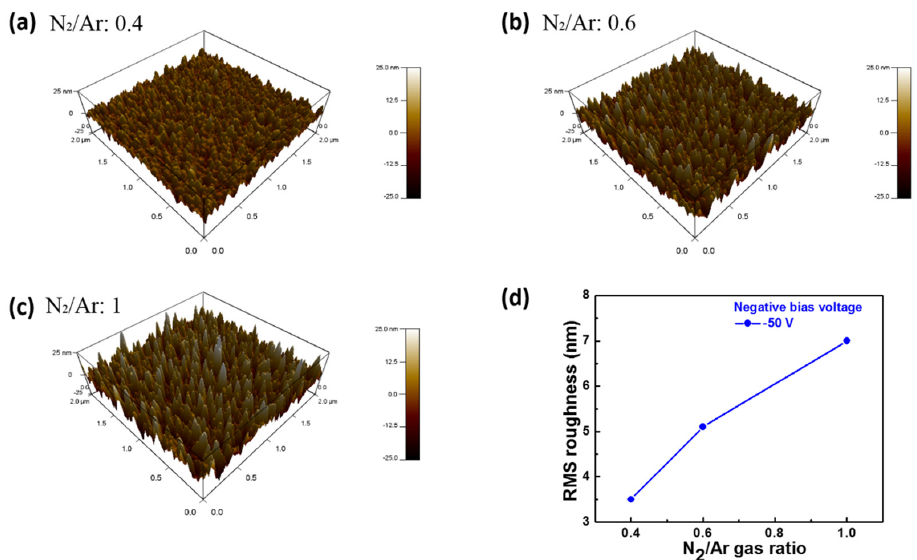
Figure 6. The three-dimensional topographic AFM images of the typical NbN x >1 samples ( a – c ), and Root Mean Square (RMS) roughness deposited at different N 2 /Ar gas ratios with constant − 50 V bias voltage ( d ).